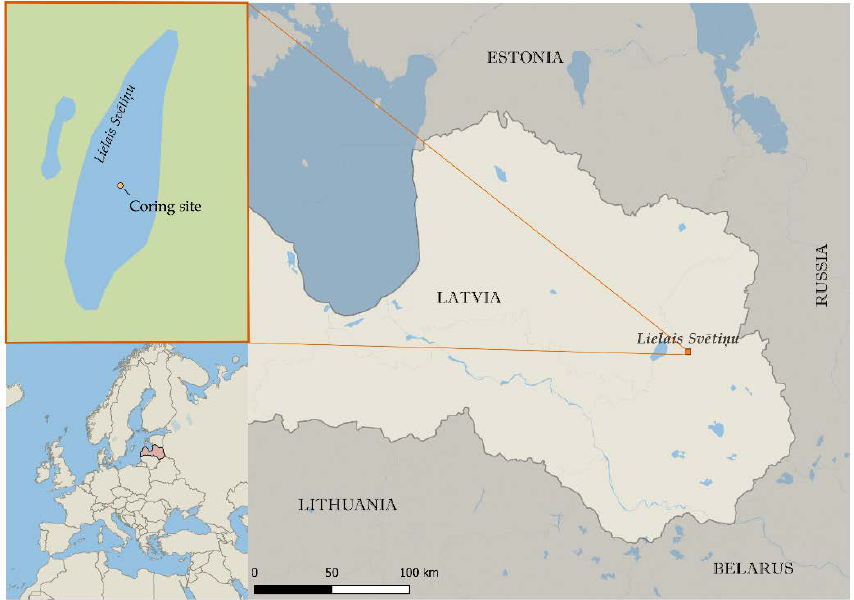
Figure 1. Map showing the location of the lake Lielais Svētiņu and coring site of analyzed sedi- ment cores taken March 2013 in Latvia.